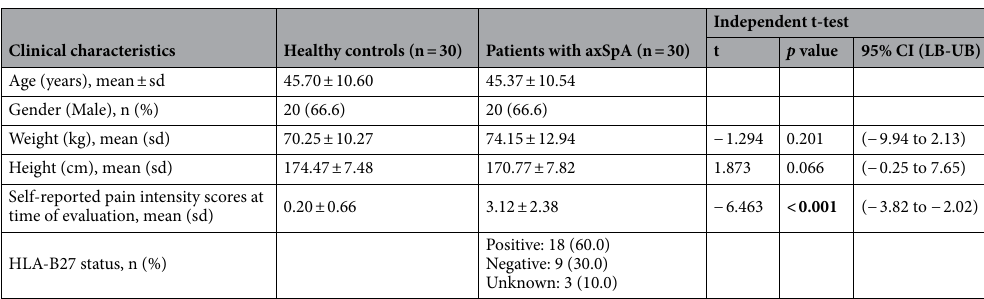
Table 2. Patients with axSpA and sex and age-matched healthy controls clinical characteristics. axSpA axial spondyloarthritis, sd standard deviation, n number, LB lower bound, UB upper bound.